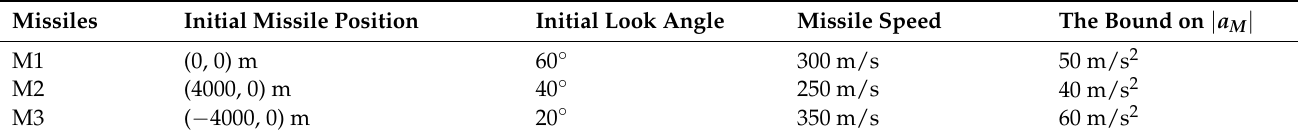
Figure 12. The results in a salvo attack. ( a ) Trajectories; ( b ) Distance to target.